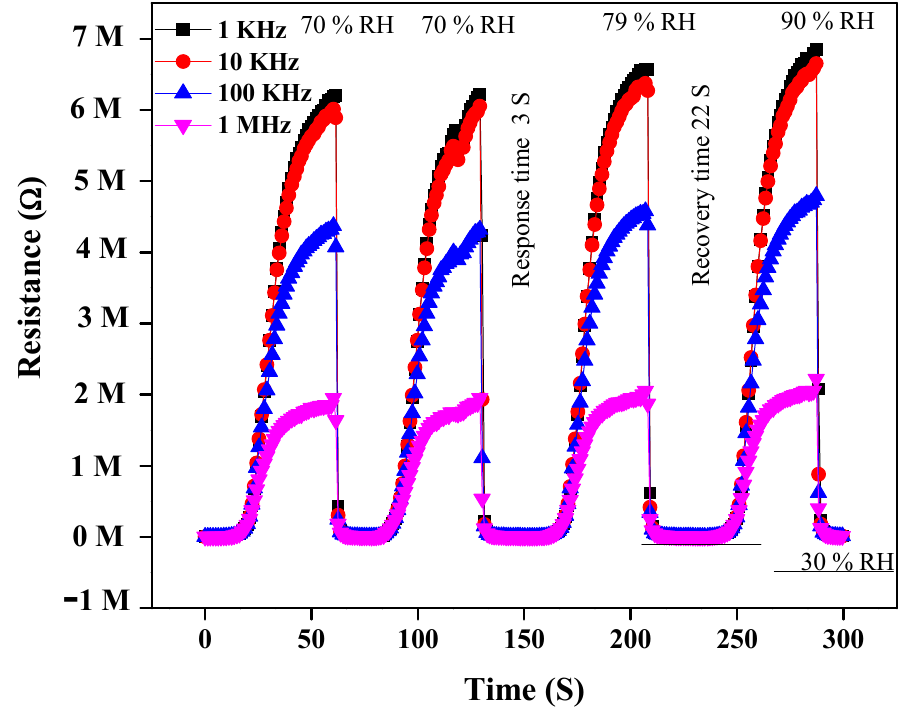
Figure 9. Resistivity response/recovery time for PEO − CuO − MWCNT: 1% nanocomposites.